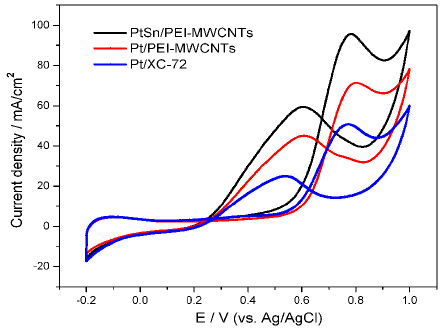
Figure 8. Cyclic voltammograms of Pt/XC72, Pt/PEI ‐ MWCNTs and PtSn/PEI ‐ MWCNTs catalysts in 0.5 M H 2 SO 4 + 1 M C 2 H 5 OH at a scan rate of 50 mV/s.